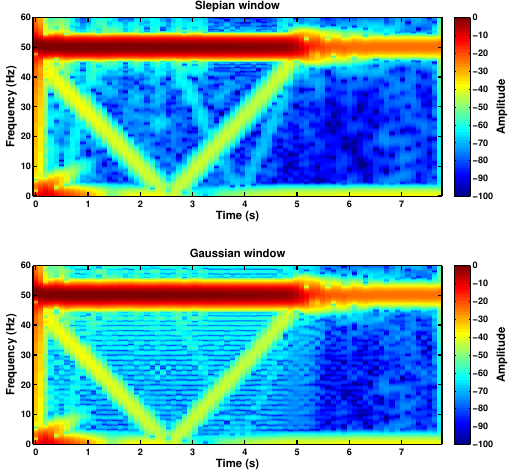
Figure 17. Reduced spectrogram of the high-power, high-voltage faulty machine given in Appendix B with a broken bar during the start-up transient using the truncated Slepian window ( top ) and using the truncated Gaussian window ( bottom